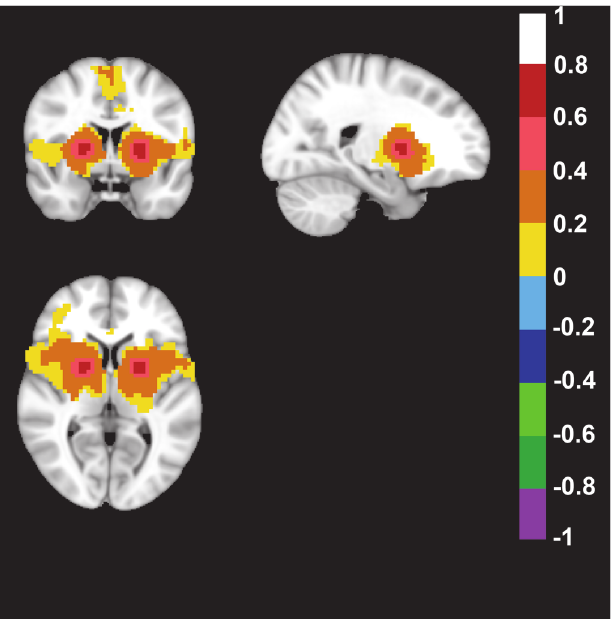
Fig 5. Human Dorsal Basal Ganglia Network. A dorsal basal ganglia network in the human brain was defined by placing a bilateral seed in Talairach coordinates in mm: +/-21; 0; 7. Top left image displays an axial, top right a sagittal and bottom image a coronal view of the human brain. Note the possitive FC-values of the bilateral putamen, as well as the supplementary motor area in the axial view, the unilateral sagittal view of putamen, and the coronal bilateral view of putamen. FC-values are displayed with a pseudo-colored scale bar; with increments of 0.2 each designated a color (see the color-bar in the image).